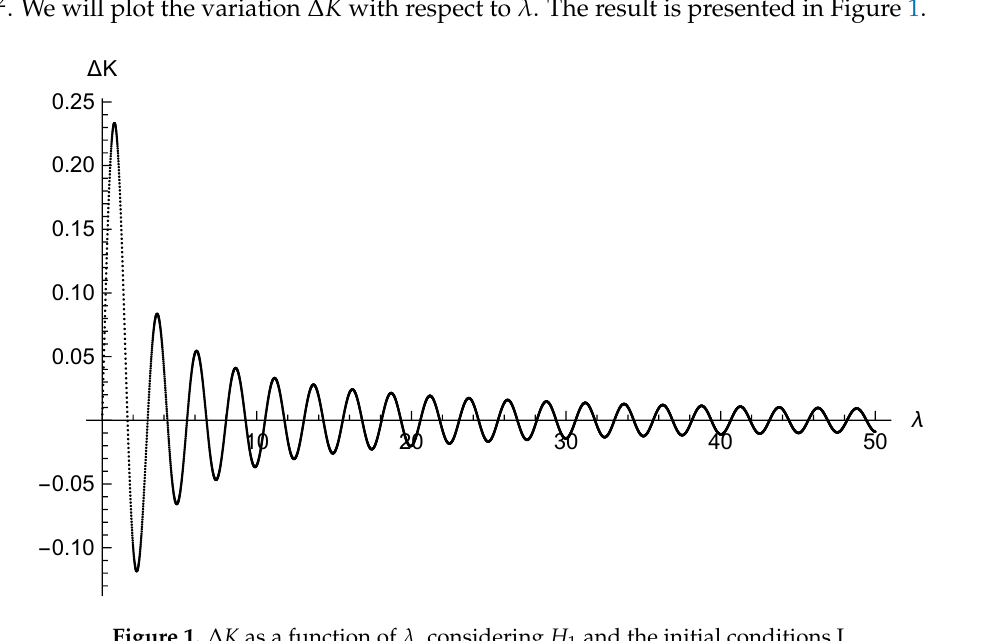
Figure 1. ∆ K as a function of λ , considering H 1 and the initial conditions I.